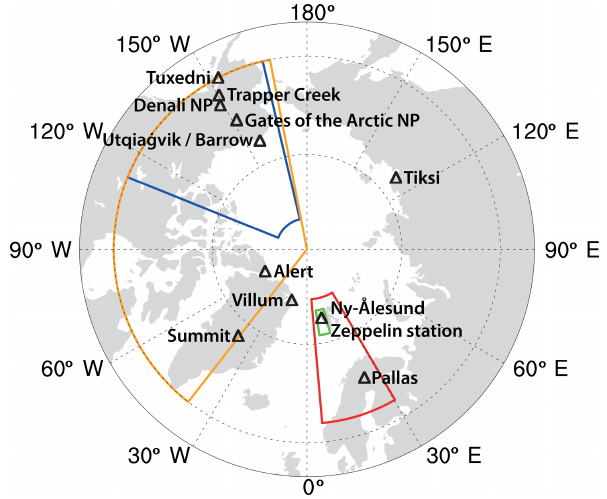
Figure 4. Geographic regions of Arctic aircraft campaigns. The data of these are used for model evaluation: HIPPO in blue, ACLOUD and PAMARCMiP-2017 in green, ACCESS in red, and ARCTAS in orange. Black triangles show the location of stations with BC surface